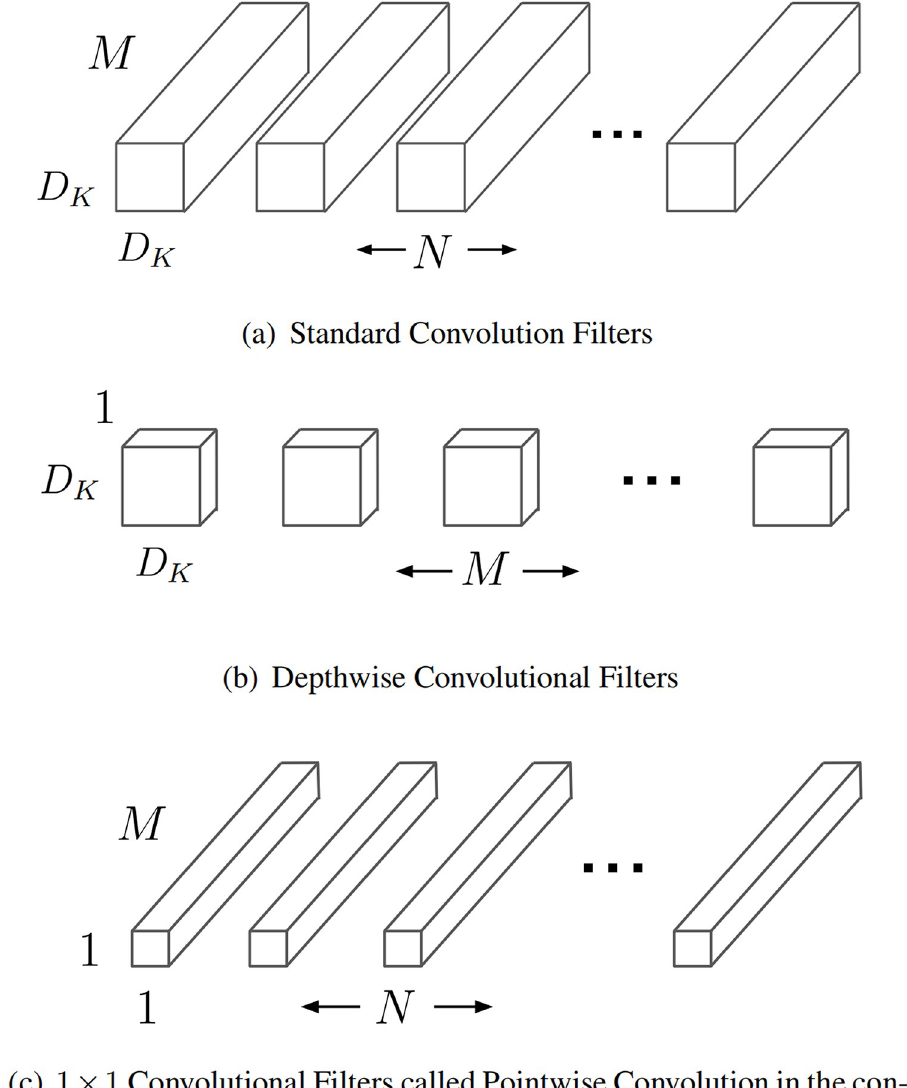
Fig 6. The standard convolutional filters in (a) are replaced by two layers: Depthwise convolution in (b) and pointwise convolution in (c) to build a depthwise separable